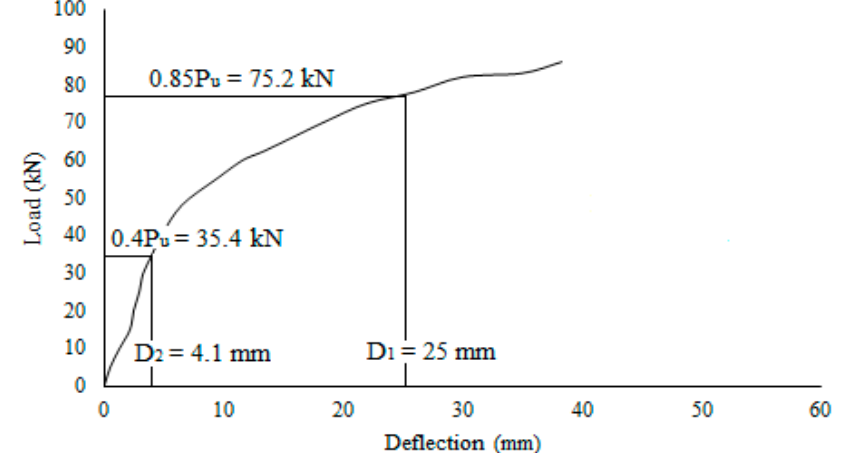
Figure 18. Ductility ratio for rectangular profiled composite slab.